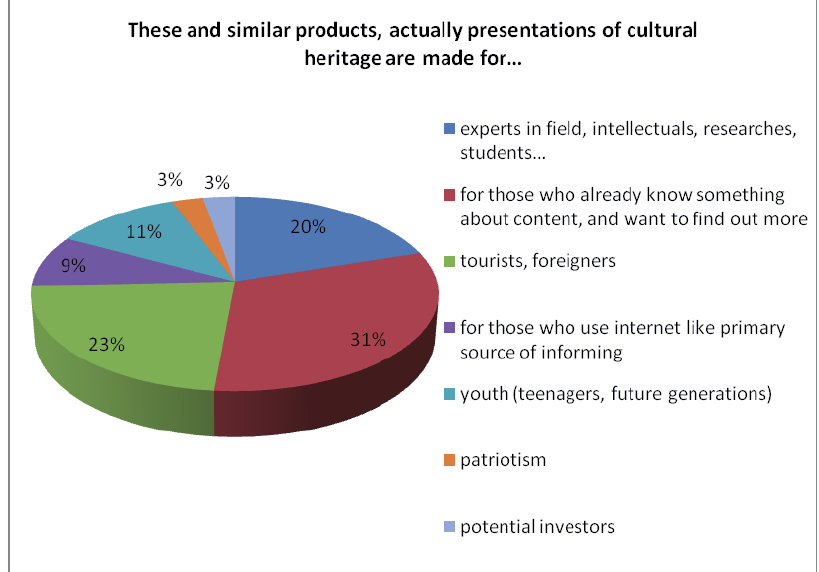
Fig. 2. The reply of the participants on the users of digital contents and resources. Source: Own chart (Lajbenšperger, & Raji ć ,